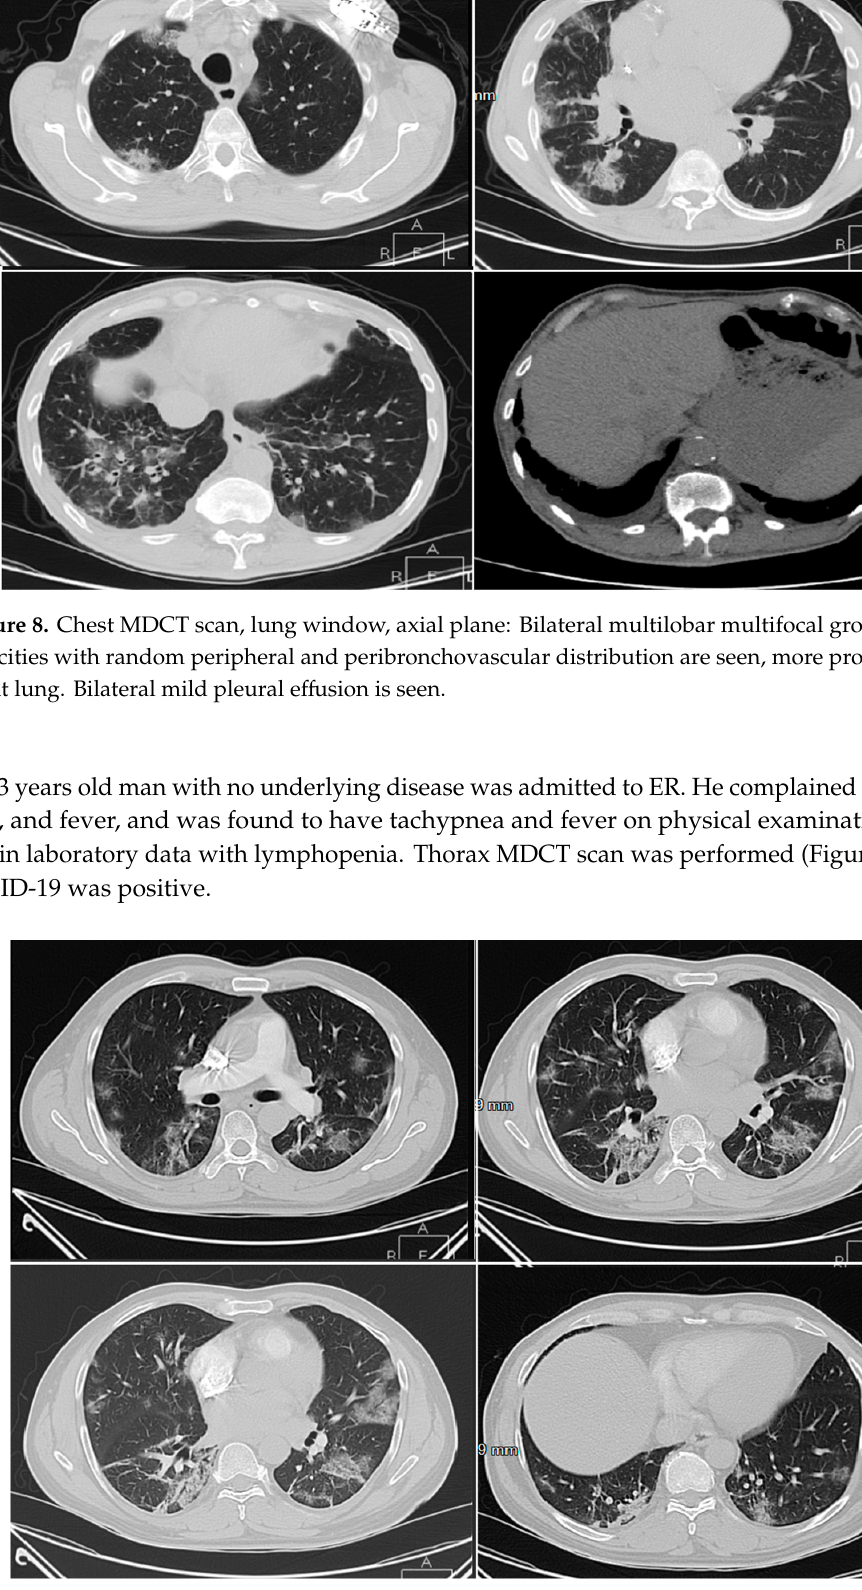
Figure 9. Chest MDCT, lung window, axial plane: Bilateral multilobar multifocal ground glass opacities with random peripheral and peribronchovascular distribution are seen.